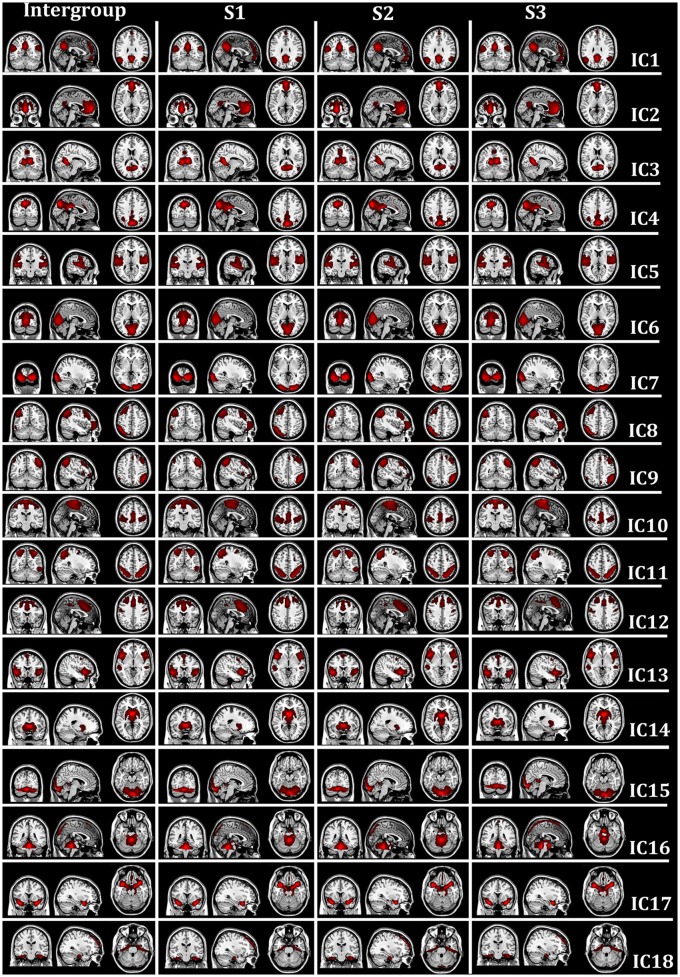
The spatial map distribution of the intrinsic BFNs at the intergroup and intragroup-specific levels on test-retest resting-state datasets: the first column depicted the intergroup intrinsic BFNs from the three rest sessions; the second, third, and fourth columns displayed the intragroup-specific intrinsic BFNs from the first (S1), second (S2), and third (S3) rest session, respectively.